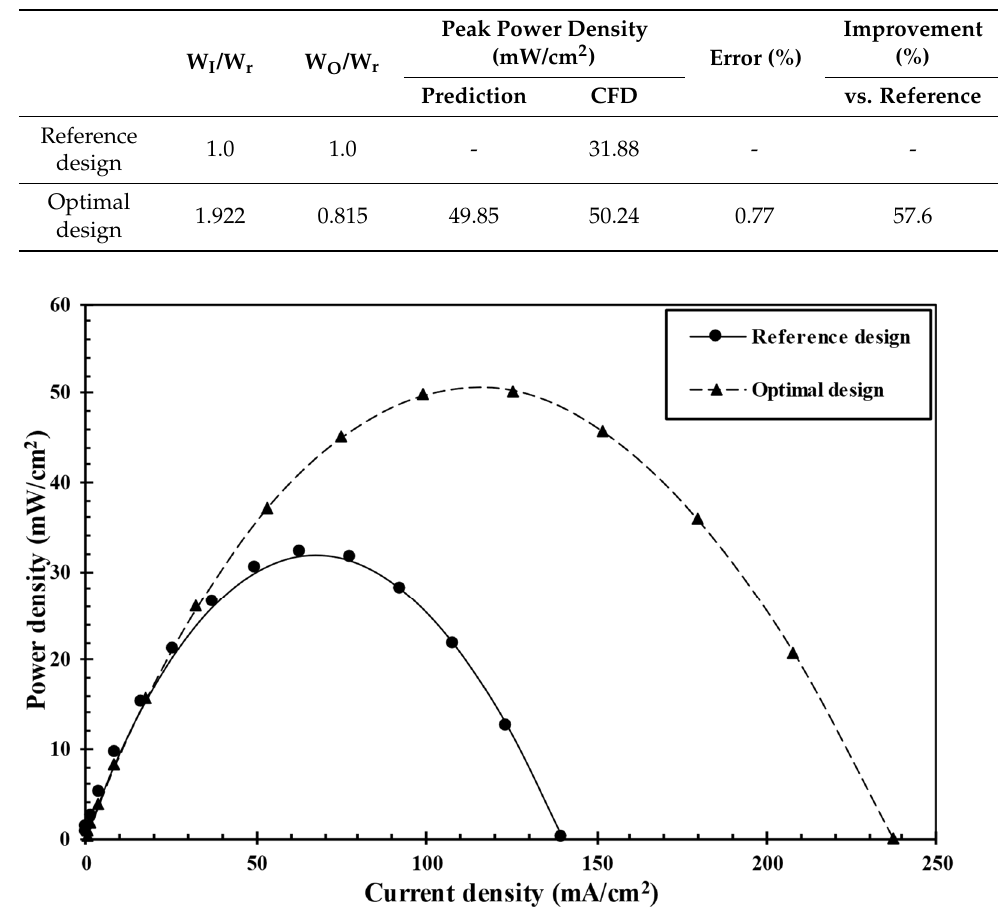
Figure 6. Comparison of performance curves between reference and optimal designs of double- bridge MMFC.